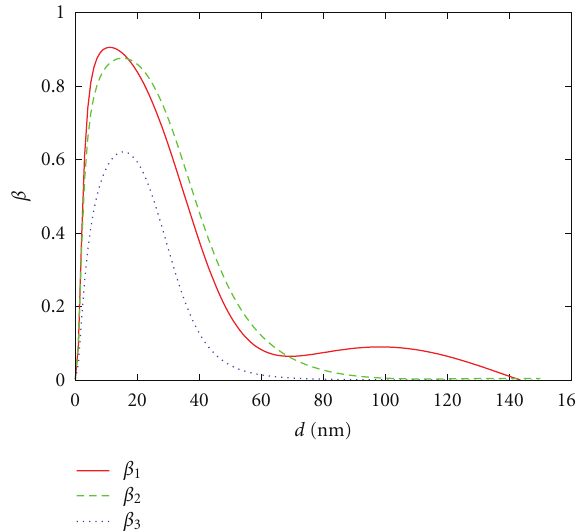
Figure 6: Coupling e ffi ciency into the dipolar ( β 1 ), quadrupolar ( β 2 ) and hexapolar ( β 3 ) mode of a R = 25nm silver sphere in PMMA, calculated using exact Mie expansion. The emitter wave- length is assumed to match the considered mode. Therefore β 1 , β 2 and β 3 are calculated at λ 1 = 435nm (dipolar resonance), λ 2 = 387nm (quadrupolar resonance), and λ 3 = 375nm (hexapolar res- onance),